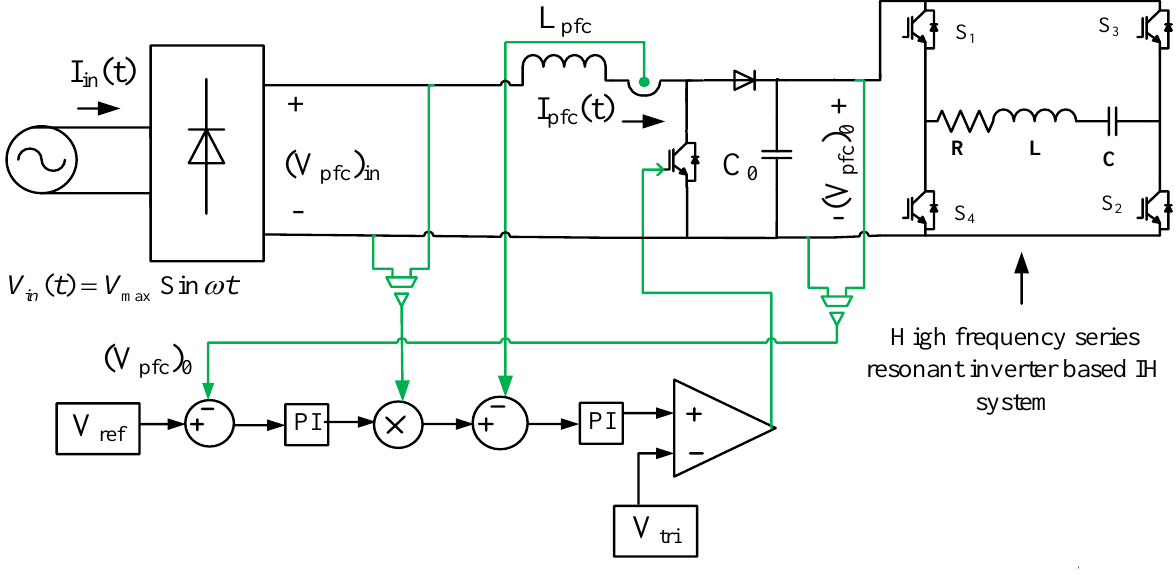
Figure 2. Proposed structure of High frequency series resonant inverter based IH system with PFC comprising of inner and outer